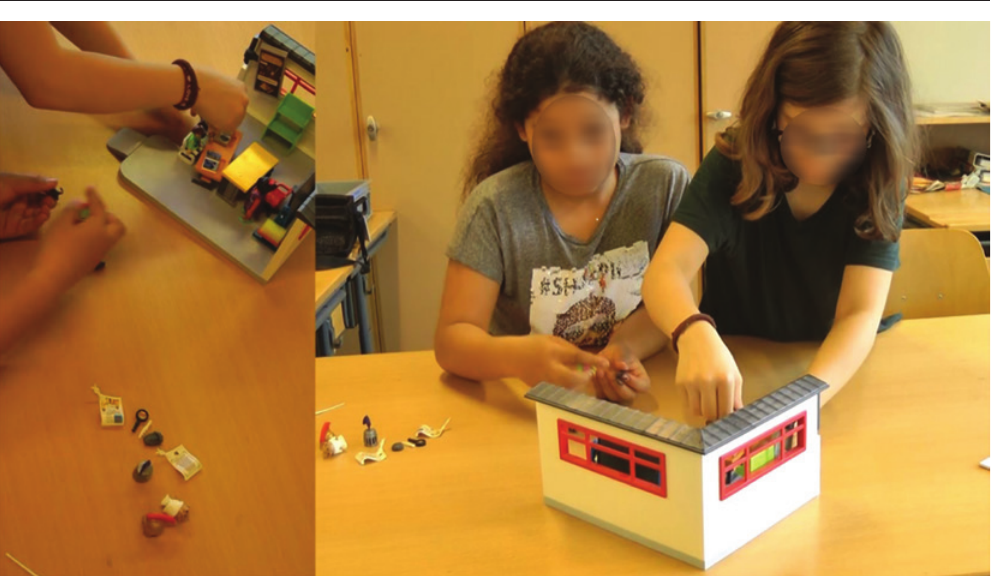
Figure 1: Children handling the toys, photographed with synchronized